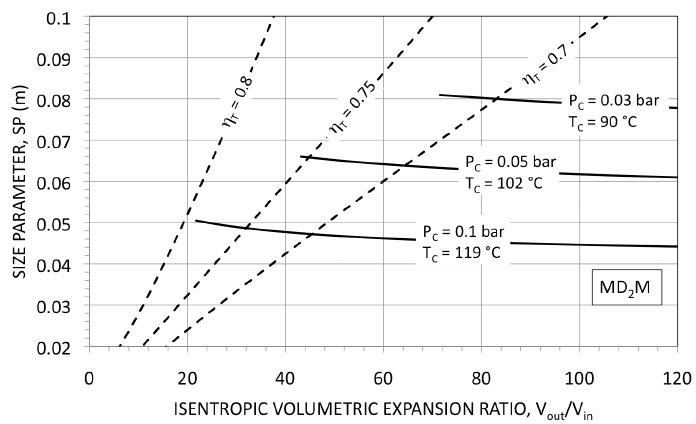
Figure 4. Turbine size parameter SP and isentropic volumetric expansion ratio for MD 2 M. The parameter η T represents the efficiency of a one-stage axial turbine. The relationship between turbine efficiency, size parameter and isentropic volumetric expansion ratio was taken from ref [36]. The solid lines are at different fixed condensation pressures P C , increasing the ratio ˙ V out / ˙ V in increases the evaporation pressure.